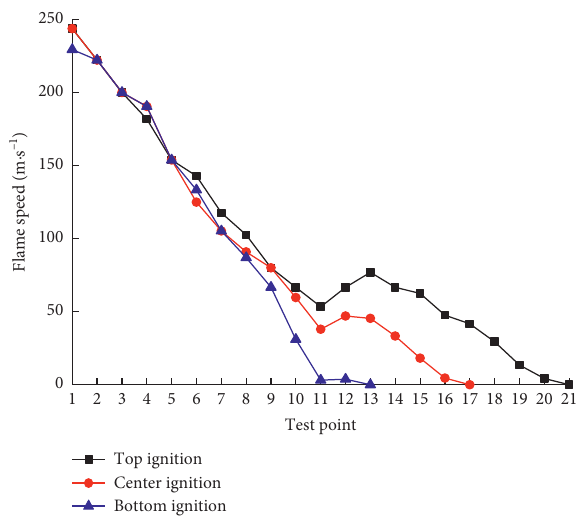
Figure 7: Curves of flame propagation velocity under different ignition